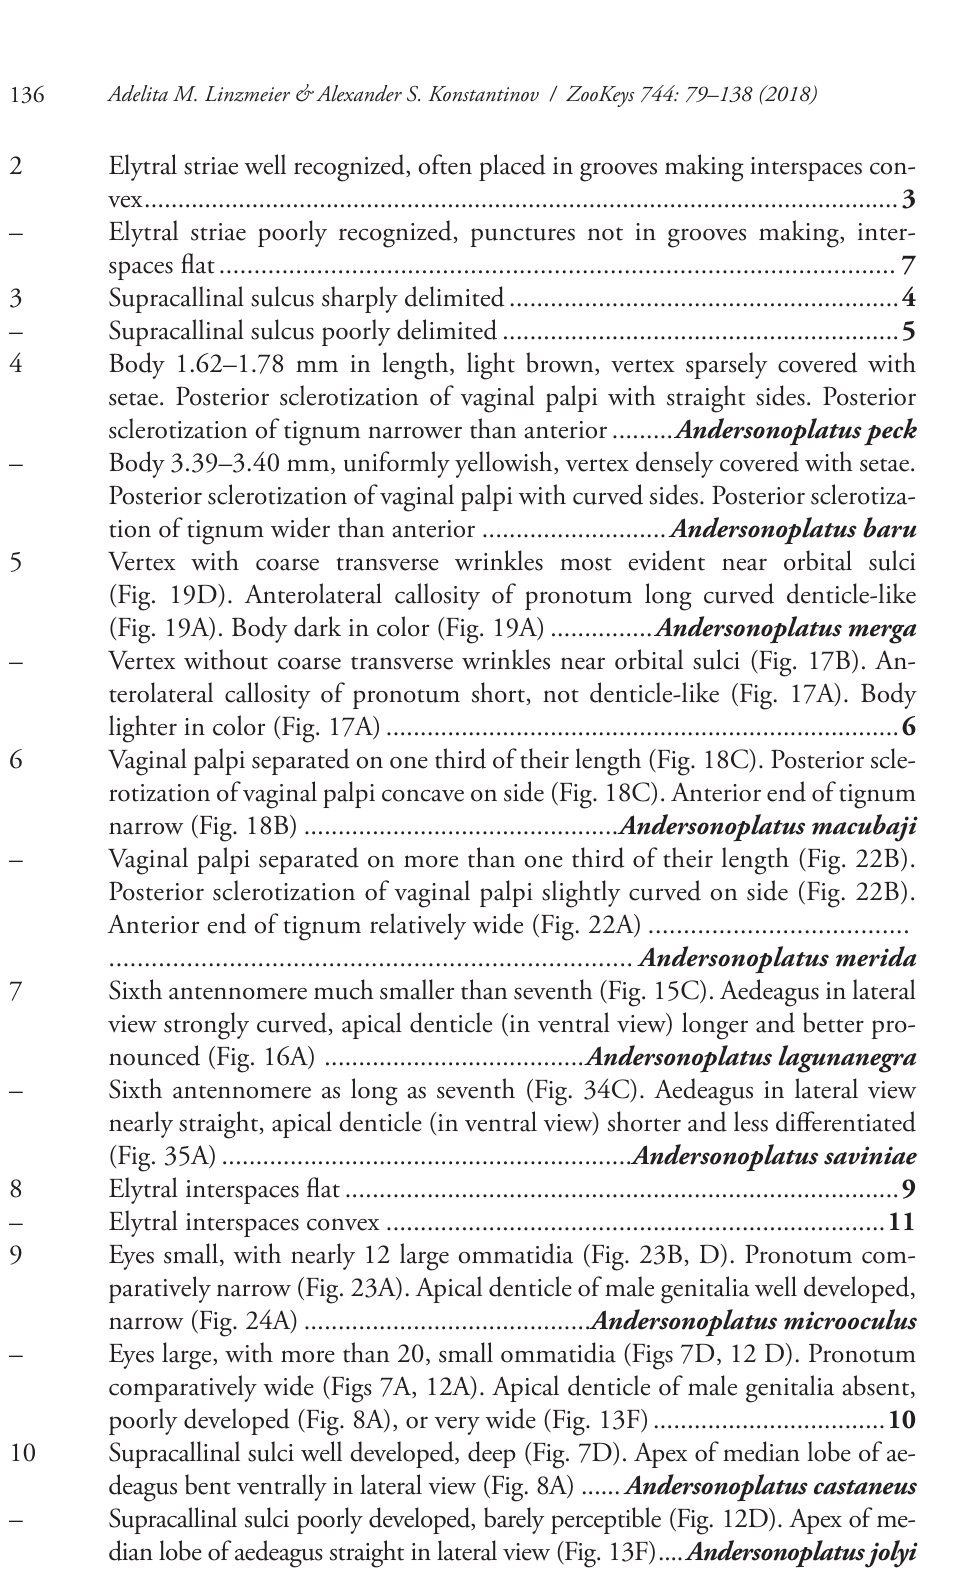
Elytral striae well recognized, often placed in grooves making interspaces con- – Elytral striae poorly recognized, punctures not in grooves making, inter- 3 – 4 Body 1.62–1.78 mm in length, light brown, vertex sparsely covered with setae. Posterior sclerotization of vaginal palpi with straight sides. Posterior sclerotization of tignum narrower than anterior ......... Andersonoplatus peck – Body 3.39–3.40 mm, uniformly yellowish, vertex densely covered with setae. Posterior sclerotization of vaginal palpi with curved sides. Posterior sclerotiza- tion of tignum wider than anterior ........................... Andersonoplatus baru 5 Vertex with coarse transverse wrinkles most evident near orbital sulci (Fig. 19D). Anterolateral callosity of pronotum long curved denticle-like (Fig. 19A). Body dark in color (Fig. 19A) ............... Andersonoplatus merga – Vertex without coarse transverse wrinkles near orbital sulci (Fig. 17B). An- terolateral callosity of pronotum short, not denticle-like (Fig. 17A). Body lighter in color (Fig. 17A) ........................................................................... 6 6 Vaginal palpi separated on one third of their length (Fig. 18C). Posterior scle- rotization of vaginal palpi concave on side (Fig. 18C). Anterior end of tignum narrow (Fig. 18B) .............................................. Andersonoplatus macubaji – Vaginal palpi separated on more than one third of their length (Fig. 22B). Posterior sclerotization of vaginal palpi slightly curved on side (Fig. 22B). Anterior end of tignum relatively wide (Fig. 22A) ..................................... .......................................................................... Andersonoplatus merida 7 Sixth antennomere much smaller than seventh (Fig. 15C). Aedeagus in lateral view strongly curved, apical denticle (in ventral view) longer and better pro- nounced (Fig. 16A) ...................................... Andersonoplatus lagunanegra – Sixth antennomere as long as seventh (Fig. 34C). Aedeagus in lateral view nearly straight, apical denticle (in ventral view) shorter and less differentiated (Fig. 35A) ............................................................ Andersonoplatus saviniae Elytral interspaces flat ................................................................................. 9 – Elytral interspaces convex ......................................................................... 11 9 Eyes small, with nearly 12 large ommatidia (Fig. 23B, D). Pronotum com- paratively narrow (Fig. 23A). Apical denticle of male genitalia well developed, narrow (Fig. 24A) .......................................... Andersonoplatus microoculus – Eyes large, with more than 20, small ommatidia (Figs 7D, 12 D). Pronotum comparatively wide (Figs 7A, 12A). Apical denticle of male genitalia absent, poorly developed (Fig. 8A), or very wide (Fig. 13F) .................................. 10 10 Supracallinal sulci well developed, deep (Fig. 7D). Apex of median lobe of ae- deagus bent ventrally in lateral view (Fig. 8A) ...... Andersonoplatus castaneus – Supracallinal sulci poorly developed, barely perceptible (Fig. 12D). Apex of me- dian lobe of aedeagus straight in lateral view (Fig. 13F) .... Andersonoplatus